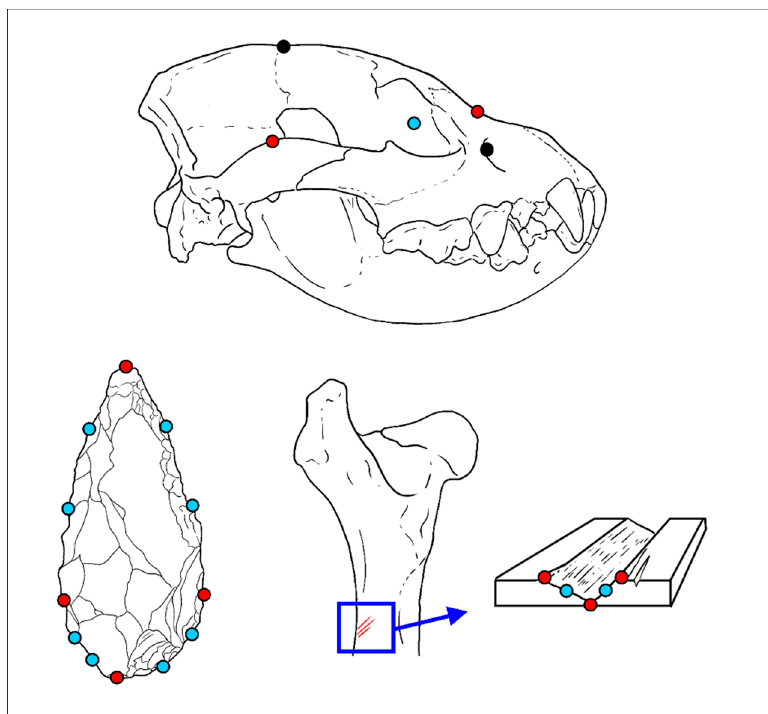
Figure 1. Examples of landmark types on different artefacts in the fossil register. Type I landmarks (black) refer to points of biological and anatomical interest, such as the meeting of two sutures or a foramen as represented on the skull above. Type II landmarks (red) are mathematically defined points of interest, such as those points marking the maximal curvature of one, the length of an item, or the deepest point in a microscopic groove. Type III landmarks (blue) are constructed points of interest located in approximation or relation with other elements, such as the centroid of an eye-socket, the general outline of an object, or points in between other landmark types.